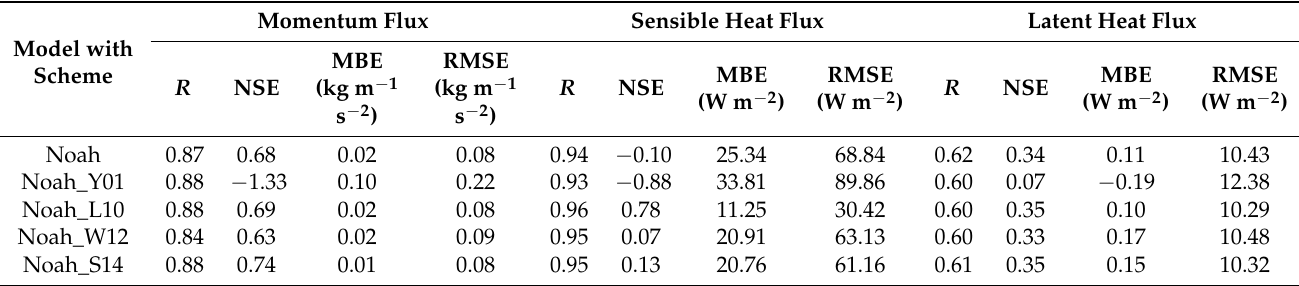
Table 2. Coefficients of correlation (R), model efficiency index (NSE), mean bias error (MBE), and root mean square error (RMSE) between observation and simulation of momentum flux, sensible heat flux, and latent heat flux.